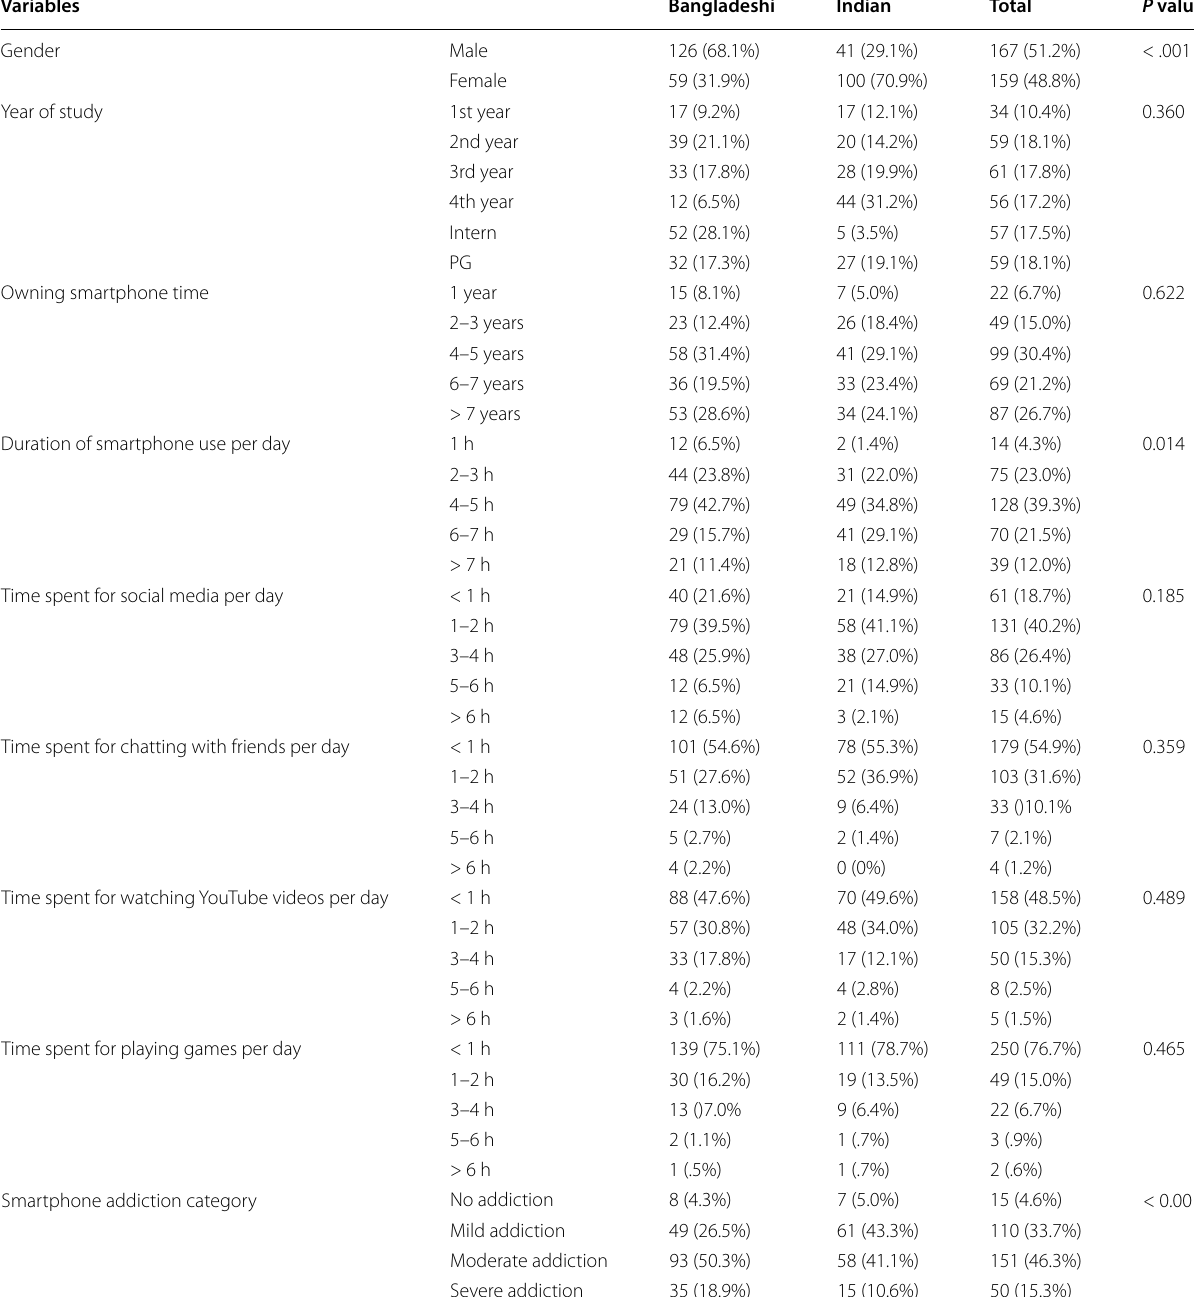
Table 1 Demographic data of the study participants